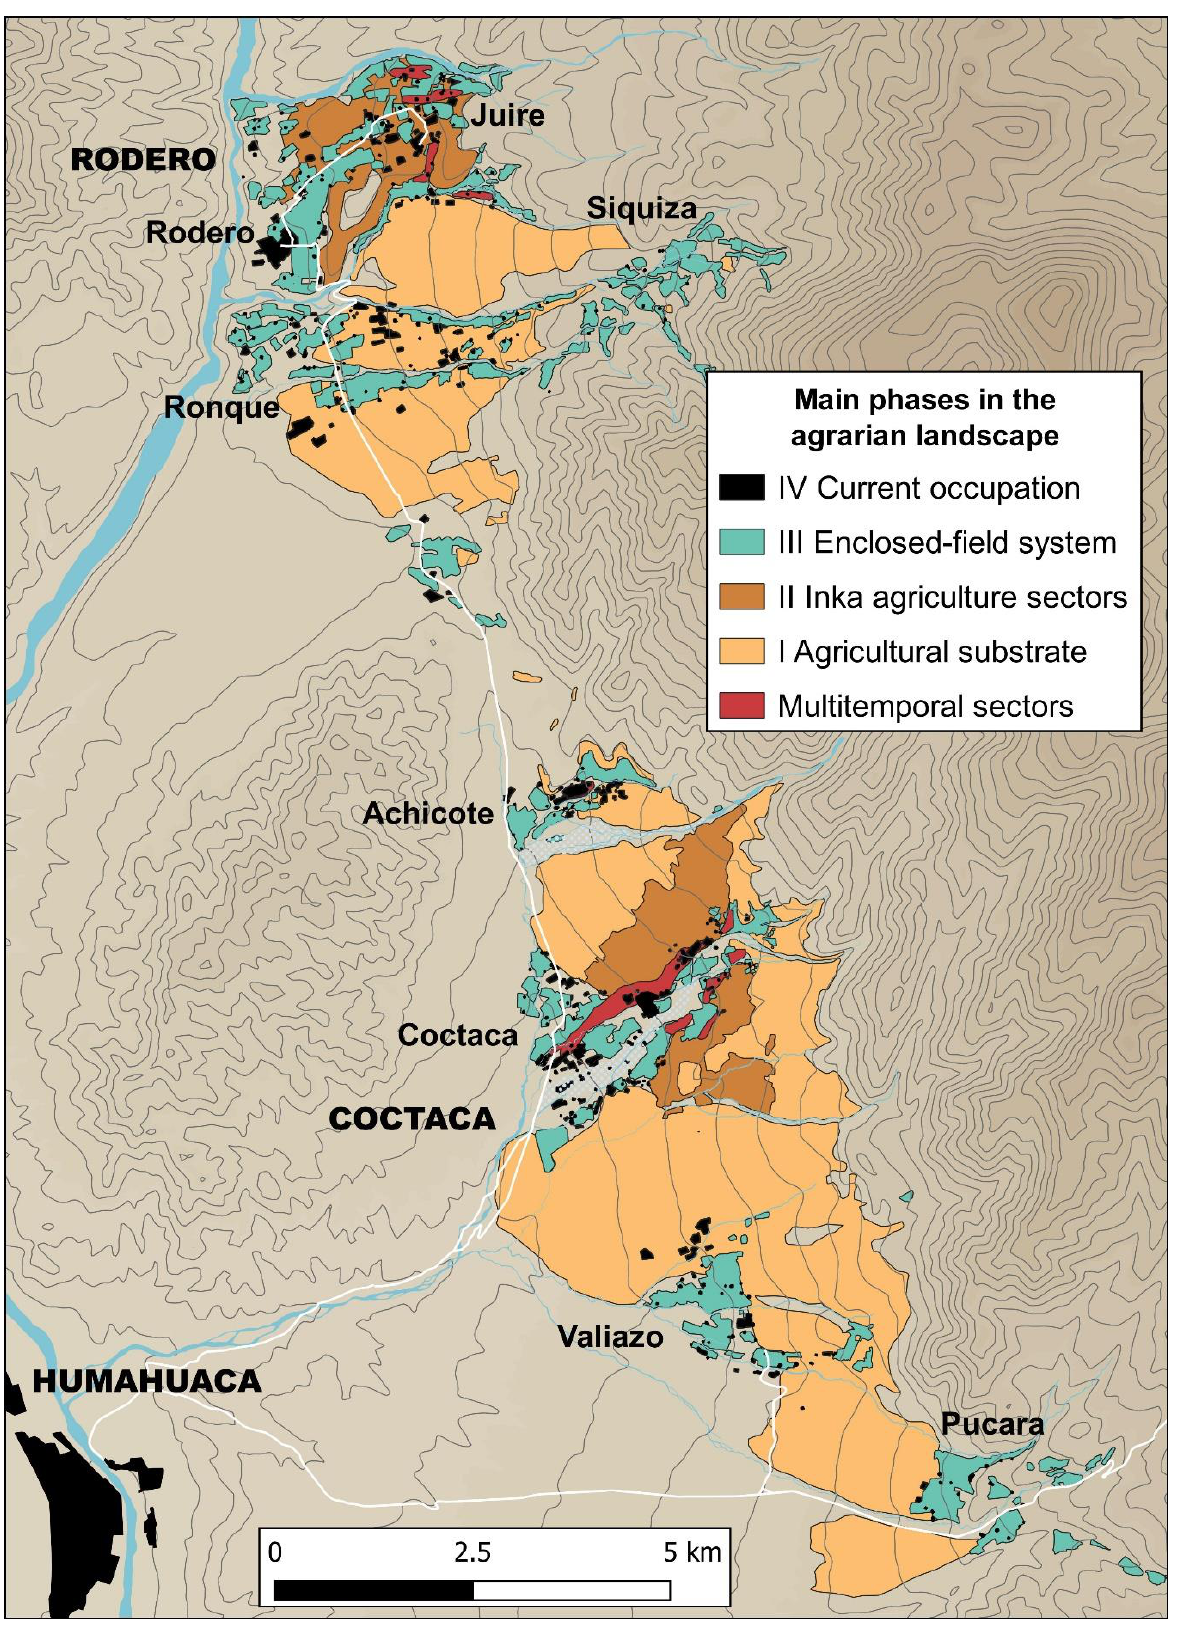
Figure 10. Distribution of the four main phases that compose the agrarian landscape of Coctaca and Rodero.